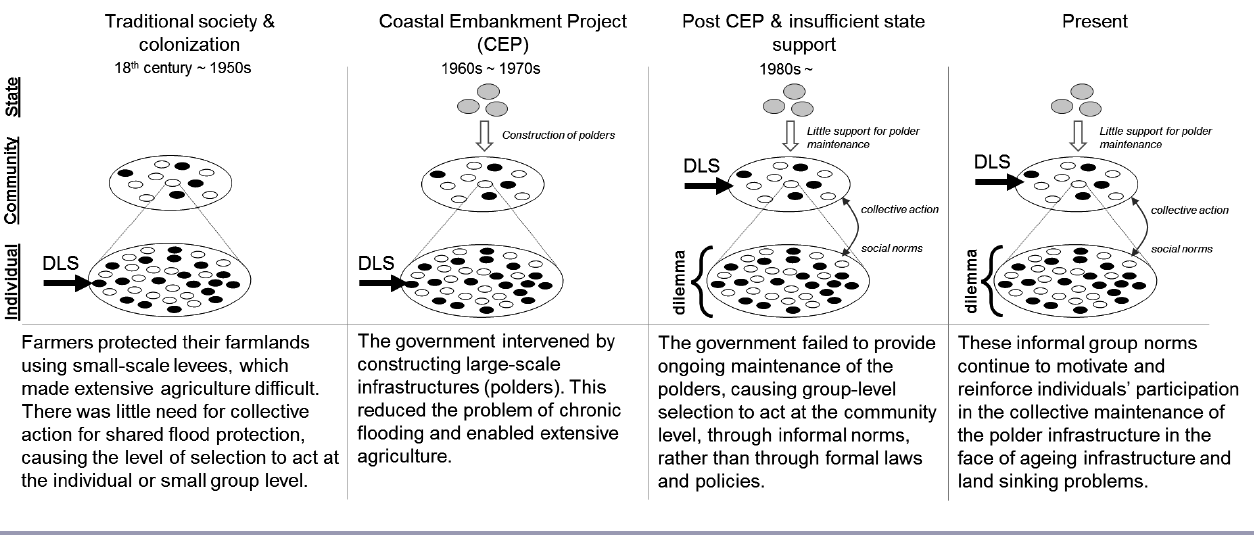
Fig. 5 . Likely changes in the level of selection for flood protection practices and policy in the Bangladesh cost (circa 18th century to present). DLS = dominant level of selection (hypothesized). White and black ovals represent social units with different cultural norms for flood protection practices. Braces ({) represent social dilemmas. Adapted from Hanes and Waring